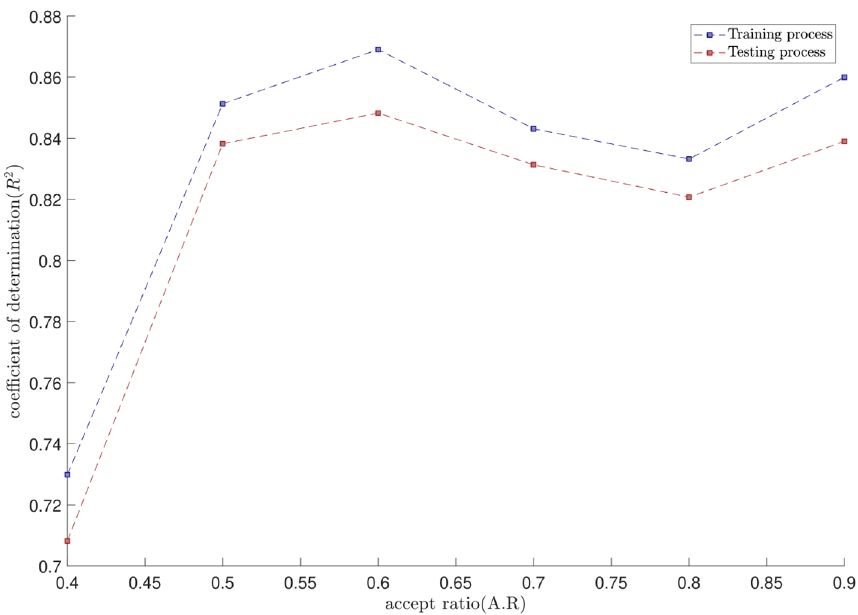
Figure 4. GAFIS method learning processes with changing in accept ratio